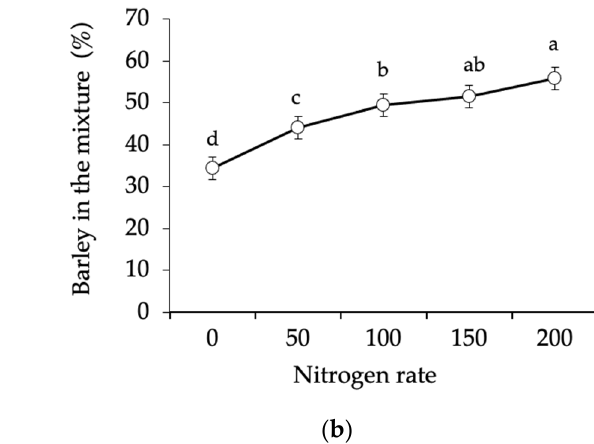
Figure 5. Indices of intercropping performances: ( a ) total forage production (DM g m − 2 ) in the equivalent surface area, per Equations (1) and (2); ( b ) percentage of barley in the forage mixture. Values are means of ( a ) two years, five N rates, two cropping systems, two harvesting stages, and three replicates (cropping system × nitrogen rate interaction) and ( b ) two years, two harvesting stages, and three replicates (Nitrogen rate main effect). Vertical lines represent HSD and values with the same letter are not statistically different for p ≤ 0.05. SC = sole crop; IC = intercrop. Averaged over the two forage harvests, the forage yielded by the IC was higher than SC, even if differently among the N rates. Without N fertilization, the IC augmented the forage yield by 74% compared to SC, but with increasing N rates, the forage yield of the SC increased more markedly than that of the IC (+95% instead of +26% from N0 to N200); at the highest N rate, the forage yield of the SC almost equalled that of the IC (scarcely +11%).